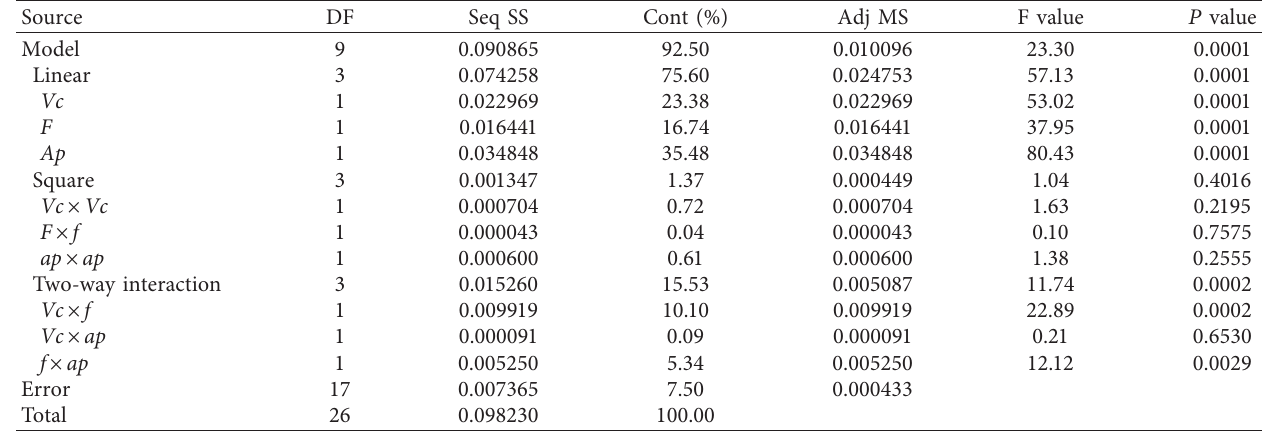
Table 5: ANOVA analysis for surface roughness.